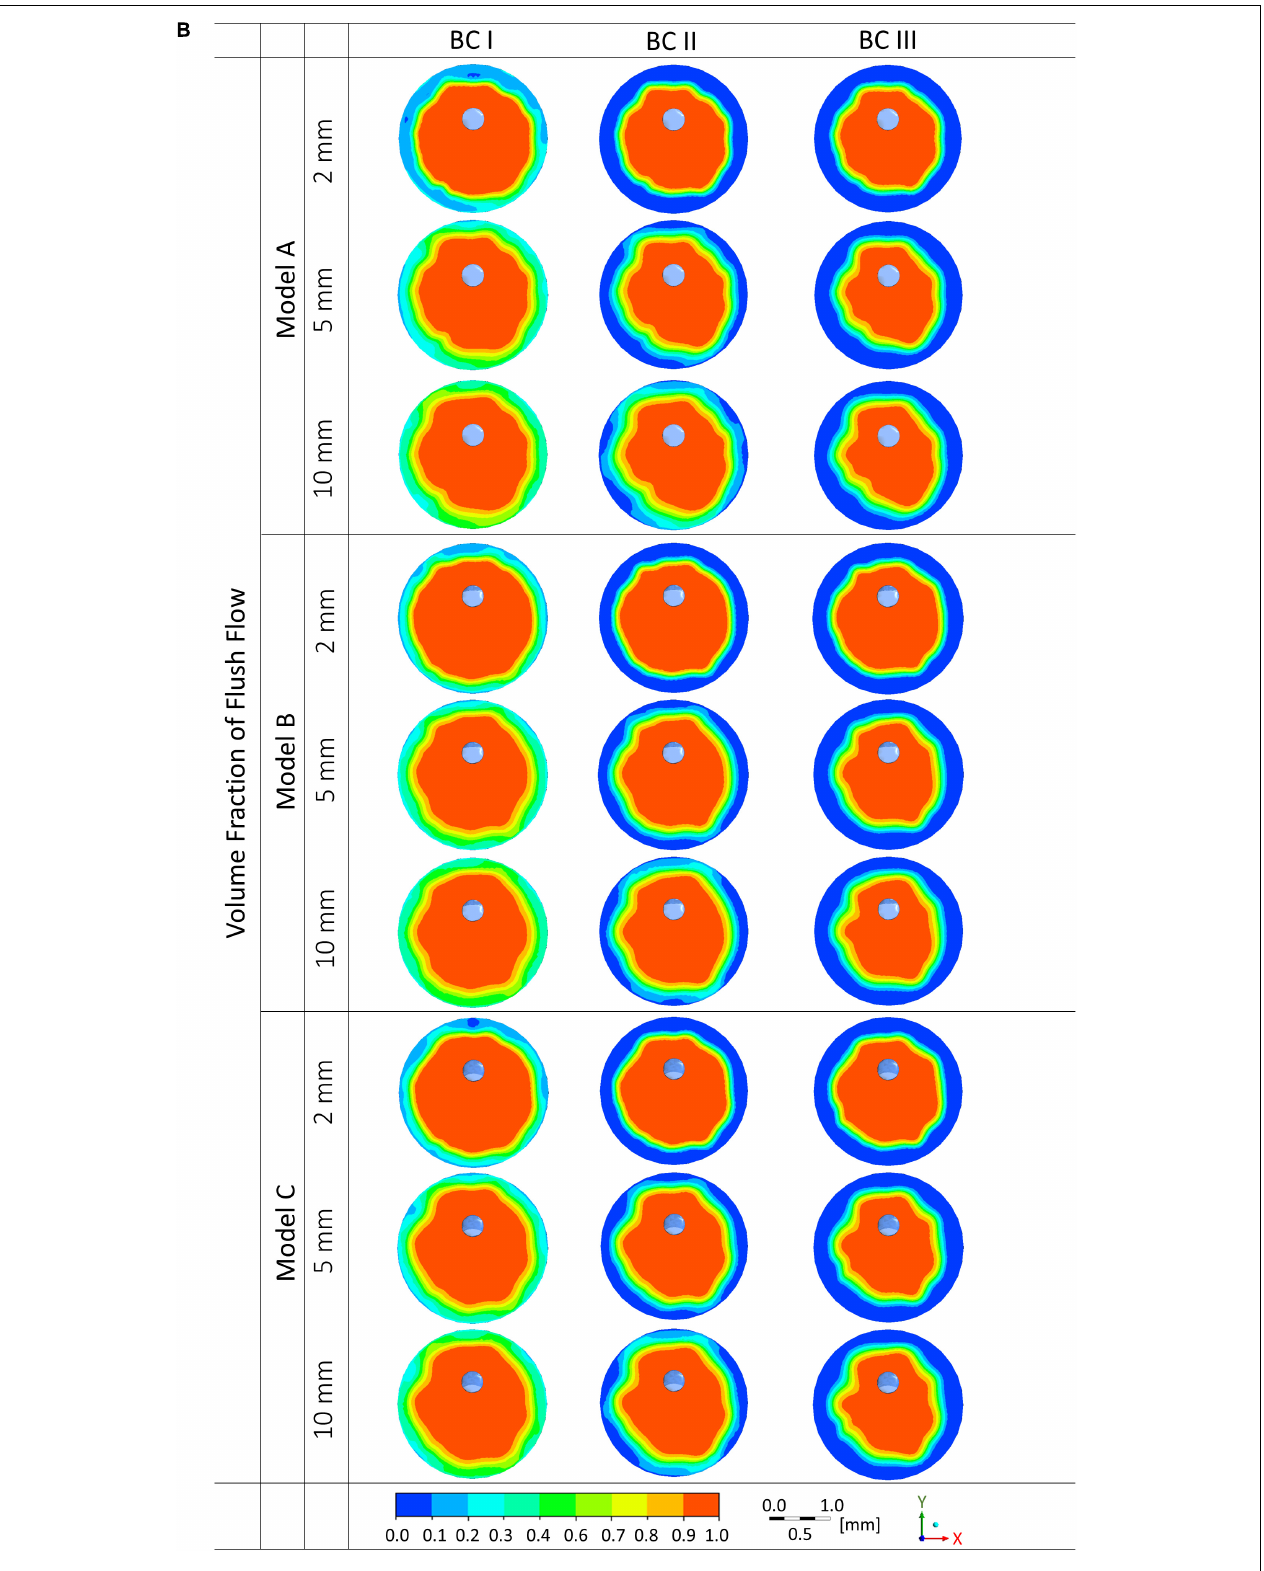
FIGURE 6 | Volume fractions of flush flow affected by endoscope morphologies and flowrates of the background blood flow at different cross-sectional planes. (A) Locations of the cross-sectional planes. (B) Volume fraction contours of the flush flow.